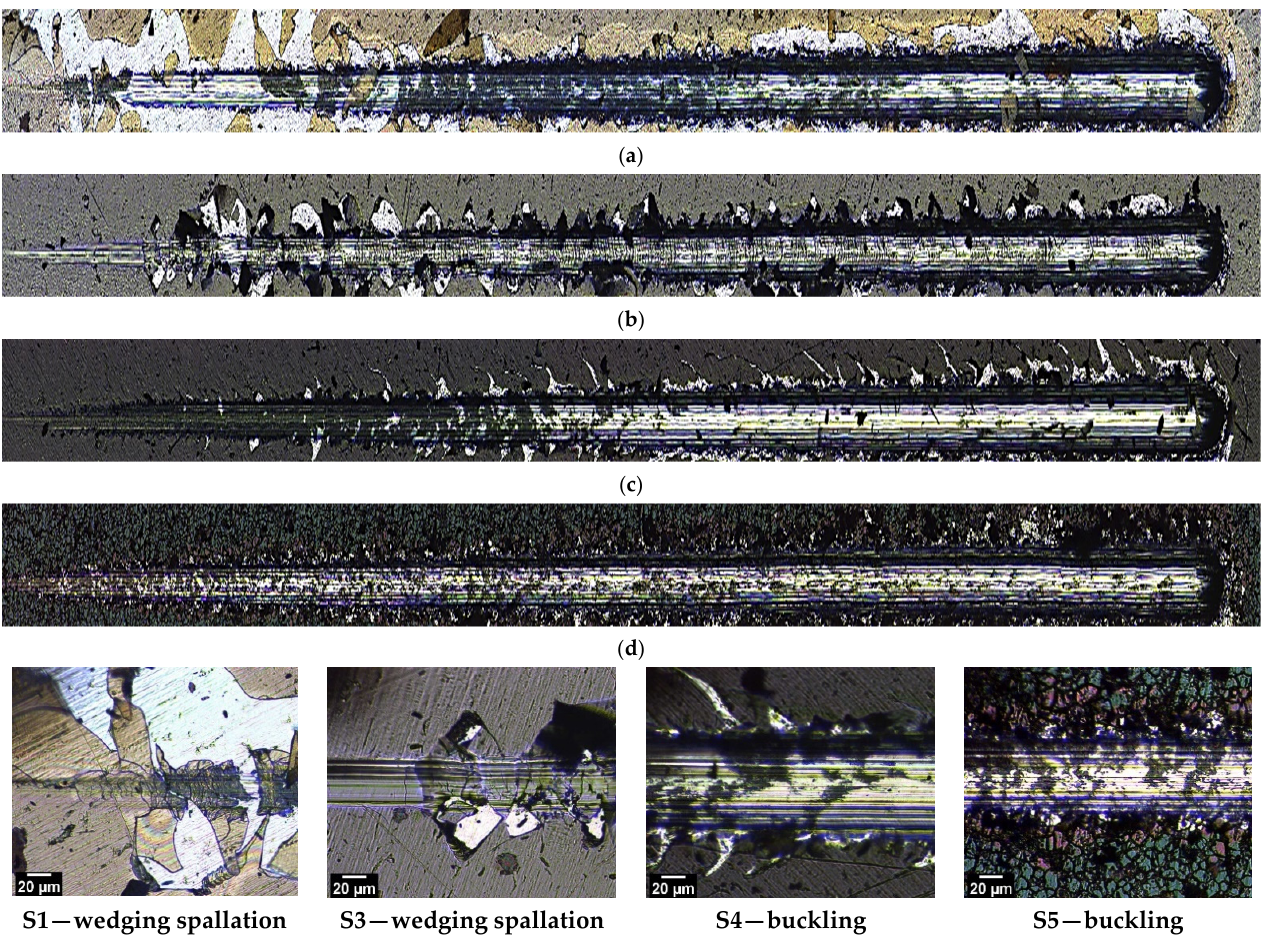
Figure 11. Coating failure due to scratch tests for S1 ( a ), S3 ( b ), S4 ( c ), and S5 ( d ); magnified optical images for interfacial failure modes overview where S1 and S3 presented a wedging spallation destructive pattern, while a buckling pattern was observed for S4 and S5.